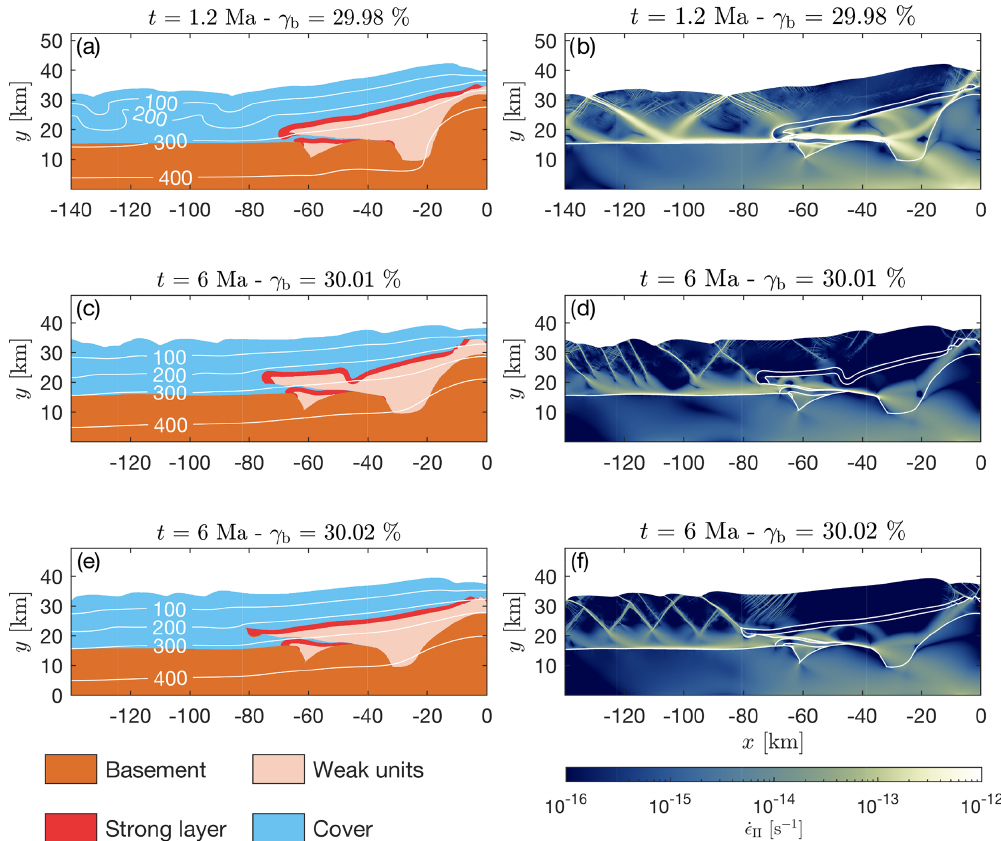
Figure 10. The geometry and the strain rate field of three simulations after approximately 30% bulk shortening, with various softening mechanisms. Panels (a) and (b) show results of a simulation with a convergence rate of 5cmyr − 1 , in which thermal softening has a significant impact. Panels (c) and (d) show results of a simulation with strain softening that reduces friction angle from the initial 30 to 5 ◦ . Panels (e) and (f) show results of a simulation with strain softening that reduces friction angle from the initial 15 to 5 ◦